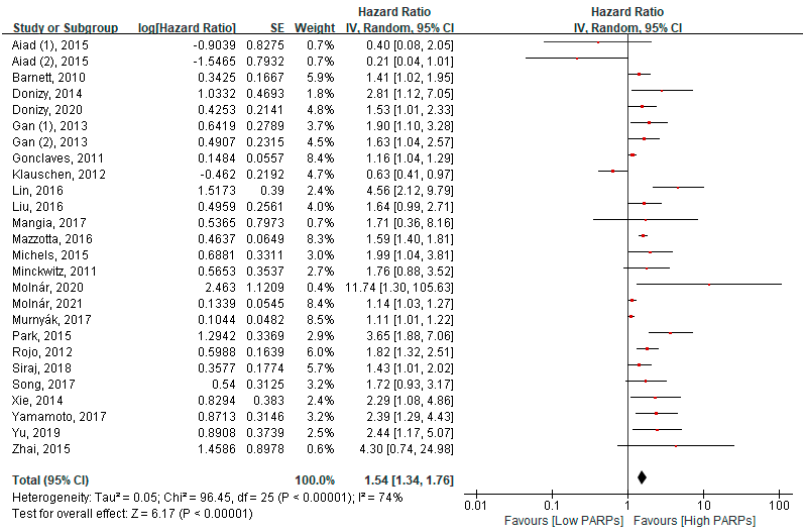
Figure 2. Forest plot of the hazard ratio for the PARP expression and overall survival in solid cancers. Regarding ethnicity, poor survival was associated with a higher expression of PARPs across different groups with almost double the HR in Asians than Caucasians (Asian: HR = 2.37, 95% CI = 1.86–3.02, p < 0.001; Caucasian: HR = 1.24, 95% CI = 1.18–1.30, p < 0.001) (Figure 3B). OS based on both univariate and multivariate analyses showed a significant associa- tion with adverse survival (univariate: HR = 1.10, 95% CI = 1.06–1.14, p < 0.001; multivari- ate: HR = 1.60, 95% CI = 1.46–1.76, p < 0.001) (Supplementary Figure S1). Regarding the sample size, only studies with more than 100 samples showed a significant association with poor OS (HR = 1.26, 95% CI = 1.20–1.33, p < 0.001) (Supplementary Figure S2A). Both direct and indirect methods (pooled HRs versus K–M curve data extraction) showed a correlation with poor OS (direct: HR = 1.58, 95% CI = 1.33–1.88, p < 0.001; indirect: HR = 1.41, 95% CI = 1.12–1.78, p < 0.001) (Supplementary Figure S2B).